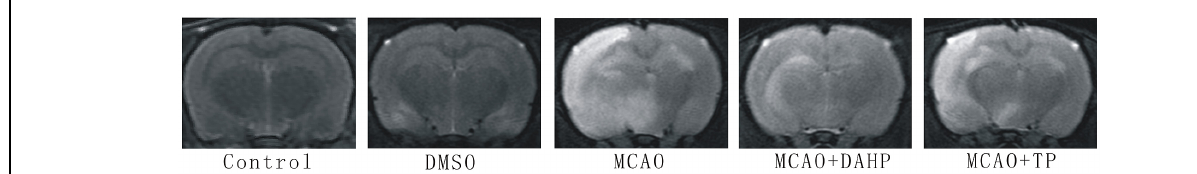
FIGURE 1 | T2-weighted MRI images of rats’ brain.